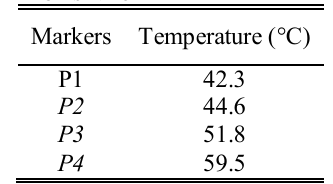
TABLE IV T EMPERATURES INDICATED BY THE THERMAL IMAGER .